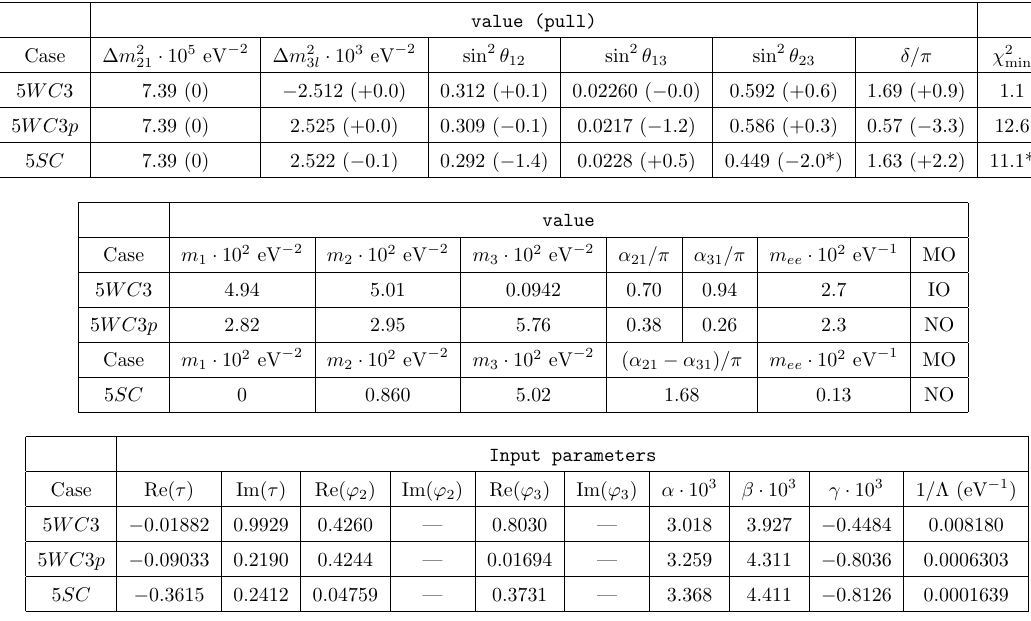
Table 8 . Results of the (cid:12)t to lepton data for the A 5 models. For the 5 SC case, the predicted lightest neutrino mass is m 1 = 0 and so only one physical Majorana phase exists, which appears in the combination ( (cid:11) 21 (cid:0) (cid:11) 31 ) in neutrinoless double beta decay and hence we report only this combination. We have (cid:12)xed ’ 1 = 1 for all three cases. (cid:3) Actual NuFit 4.0 error on sin 2 (cid:18) 23 measurement (for NO) used, rather than assumed Gaussian error. To simplify the notation, the factors cos ^ (cid:12) and 1 = sin 2 ^ (cid:12) have been omitted from (cid:11) , (cid:12) , (cid:13) and (cid:3),